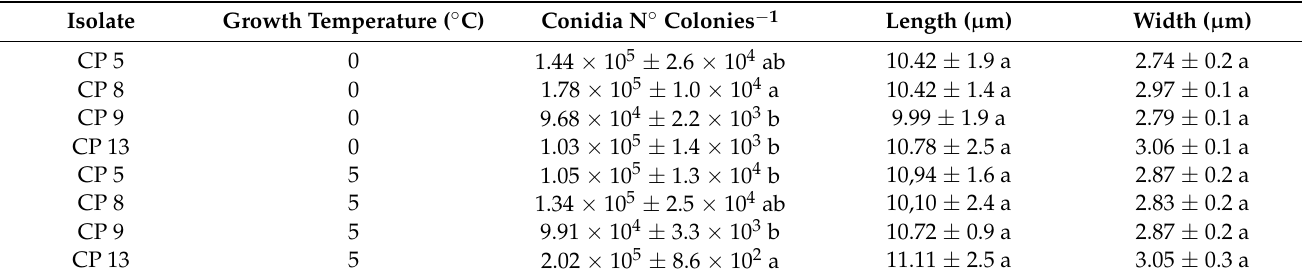
Different letters in the same column indicate statistical differences according to Tukey HSD test ( p <